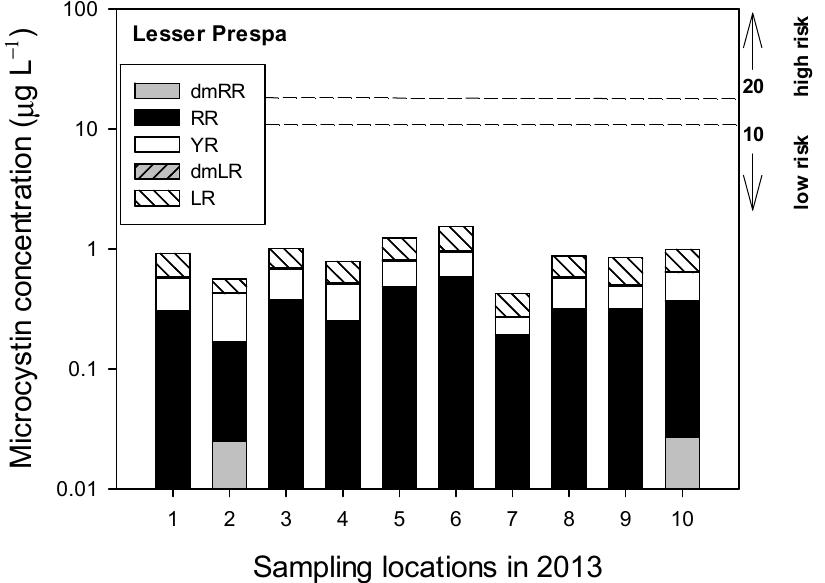
Figure 5. Concentrations ( μ g L − 1 ) of different microcystin variants measured in samples collected on 3 September 2013 at ten sites in Lake Lesser Prespa (1–10). The dashed lines indicate levels below or above which the health risk associated with recreational activities may be low or high [41]. MC-variants LY, LW, LF and nodularin (NOD) were not detected.